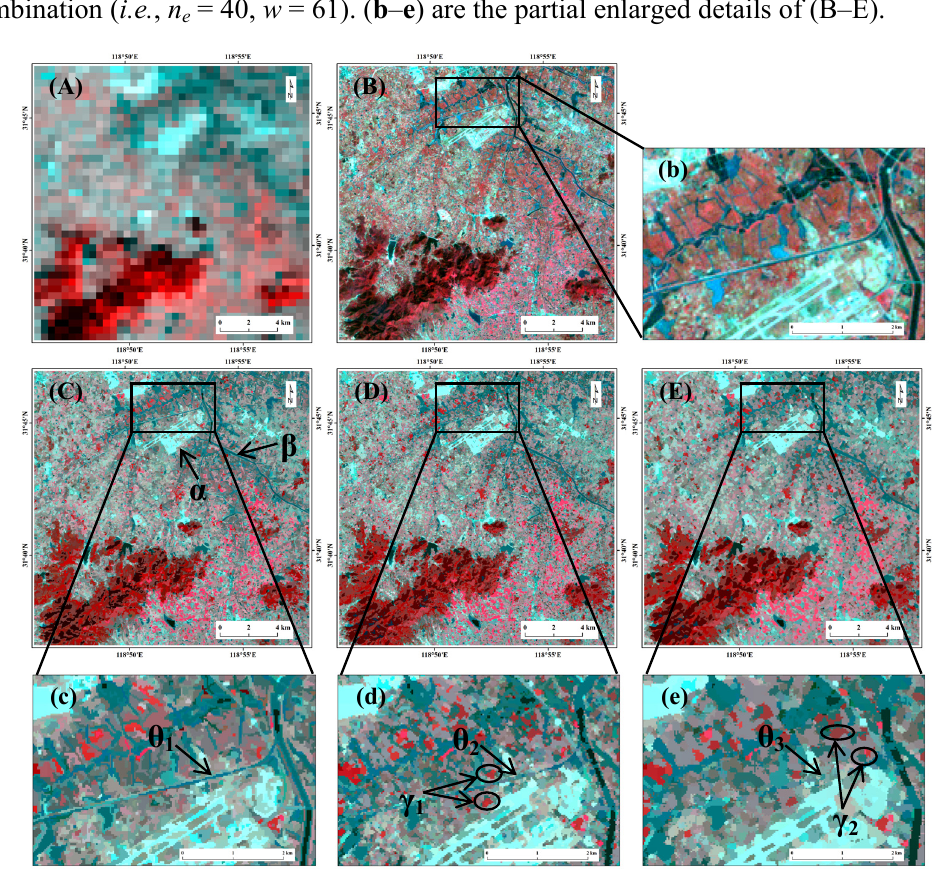
Figure 8. NIR-red-green composites of MOD09GA images ( A ) and ETM+ images ( B ) on 8 October 2002 and comparisons between the different unmixed images of the patch-based ISODATA classification ( C ), and the Majority Analysis Method1 (3 × 3 transfer kernel) ( D ), the Majority Analysis Method2 (5 × 5 transfer kernel) ( E ) with the optimal parameter = 40, w = 61). ( b – e ) are the partial enlarged details of combination ( i.e. , n e